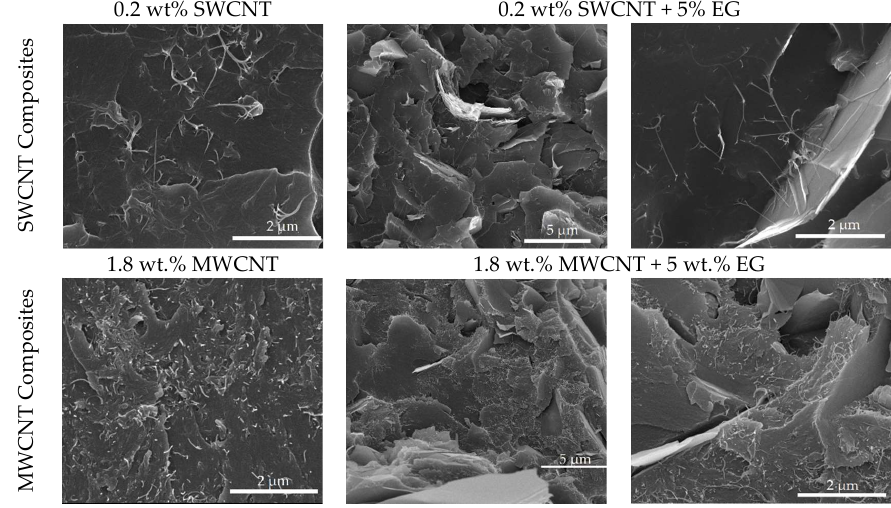
Figure 5. SEM micrographs of selected epoxy nanocomposites.